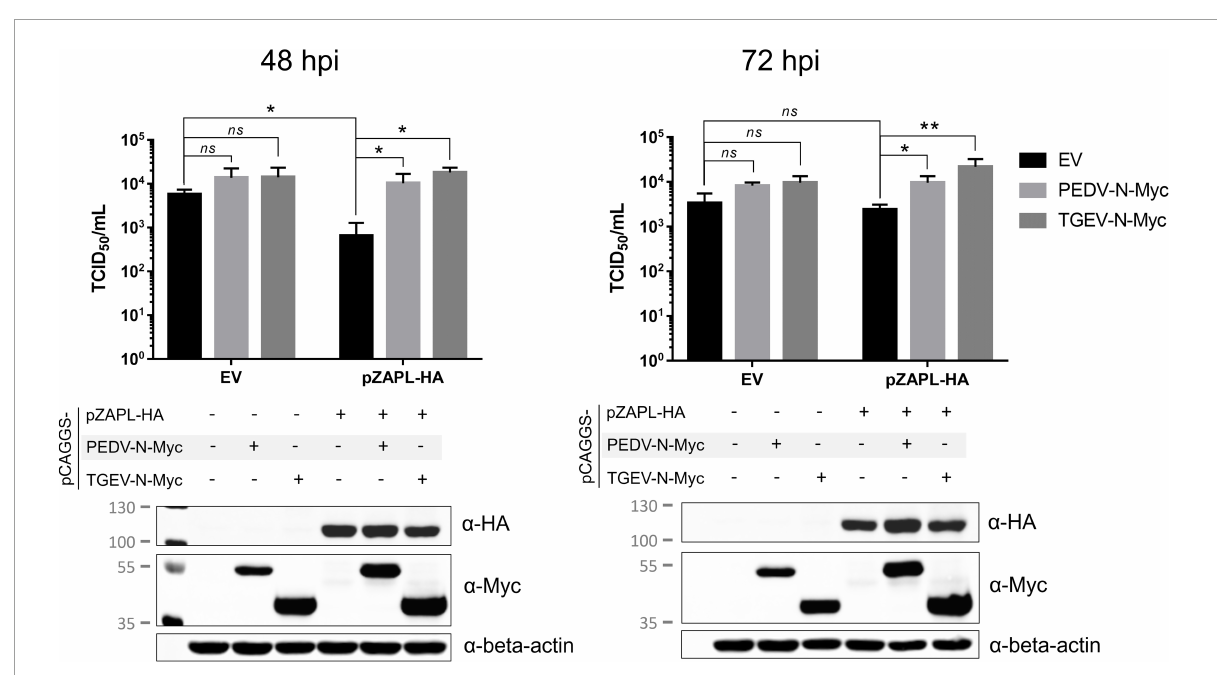
FIGURE8 Suppression of CPD-porcine epidemic diarrhea virus (PEDV) growth by pZAPL can be reversed by pCoV-Ns. VeroE6 ZAP-KO cells were transfected with the indicated plasmids. At 24 hpt, transfected cells were infected with CPD-PEDV (MOI = 0.001). Supernatants were collected at 48 and 72 hpi to determine viral titers using the TCID 50 assay. Expression of the indicated proteins is shown by SDS-PAGE/western blot results below. Values shown are averages ± SEM of three independent experiments (Student’s t -test, * p < 0.05, ** p <